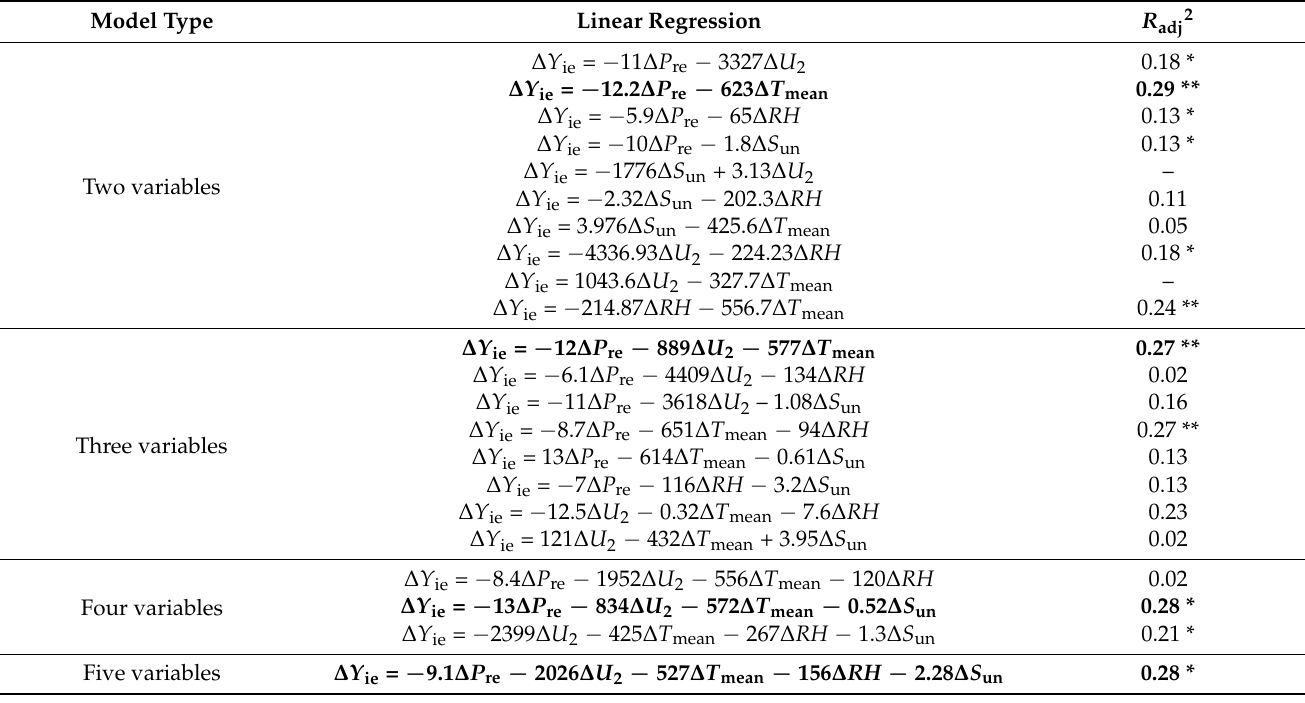
Table 5. The multivariate linear equations for ∆ Y ie correlated with two to five climatic variables and their performance at site Wusu.